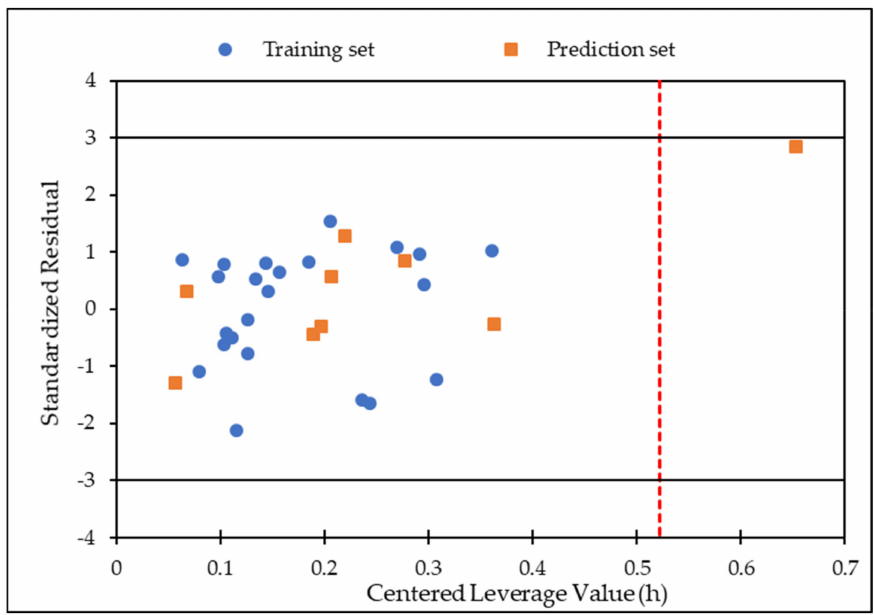
Figure 3. Applicability domain plot of standardized residuals versus centered leverage value of model 3.